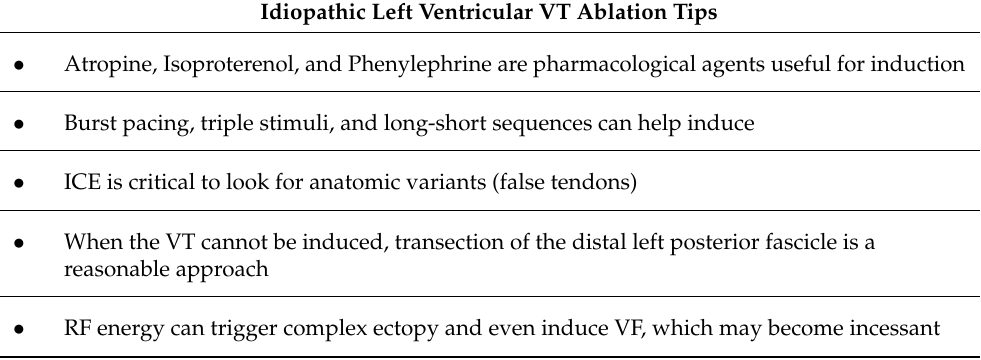
Table 3. Summary of IL-VT ablation